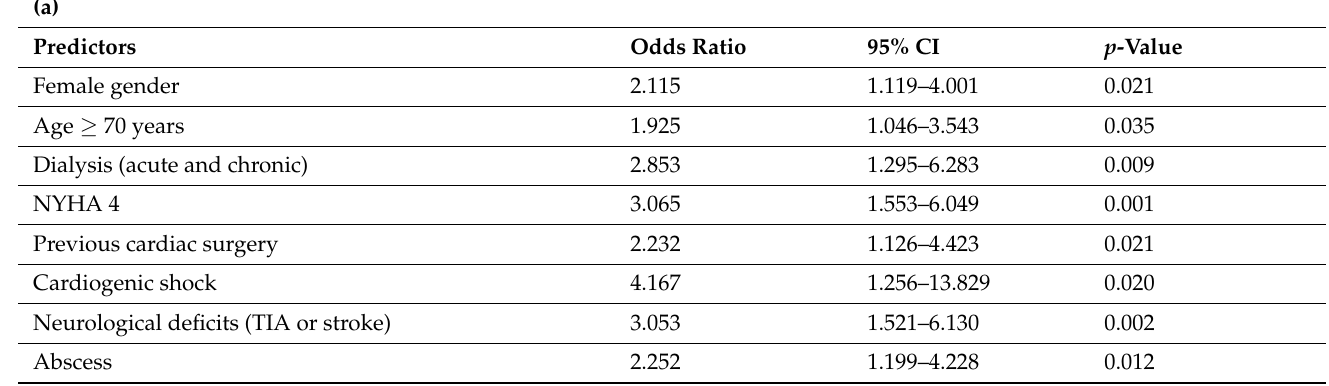
Table 1. (a) Logistic regression analysis for 30-day mortality in all endocarditis patients. (b)